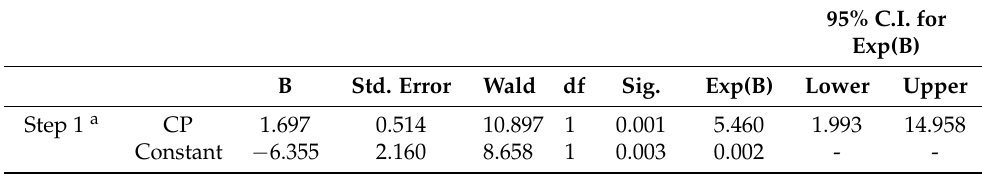
Table 27. Competitive Pressure: Regression Analysis for IaaS.